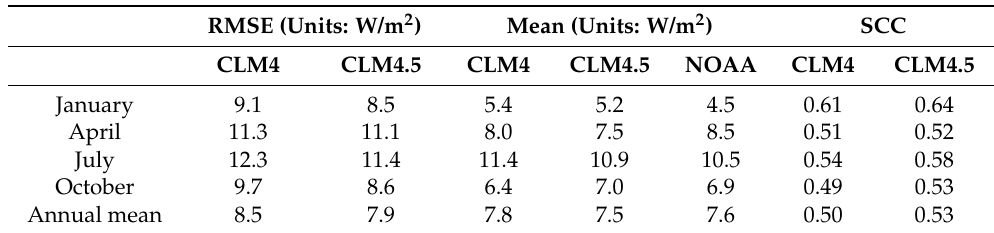
Table 4. RMSEs, means and spatial correlation coefficients (SCC) for globally Es in January, April, July and October and annual